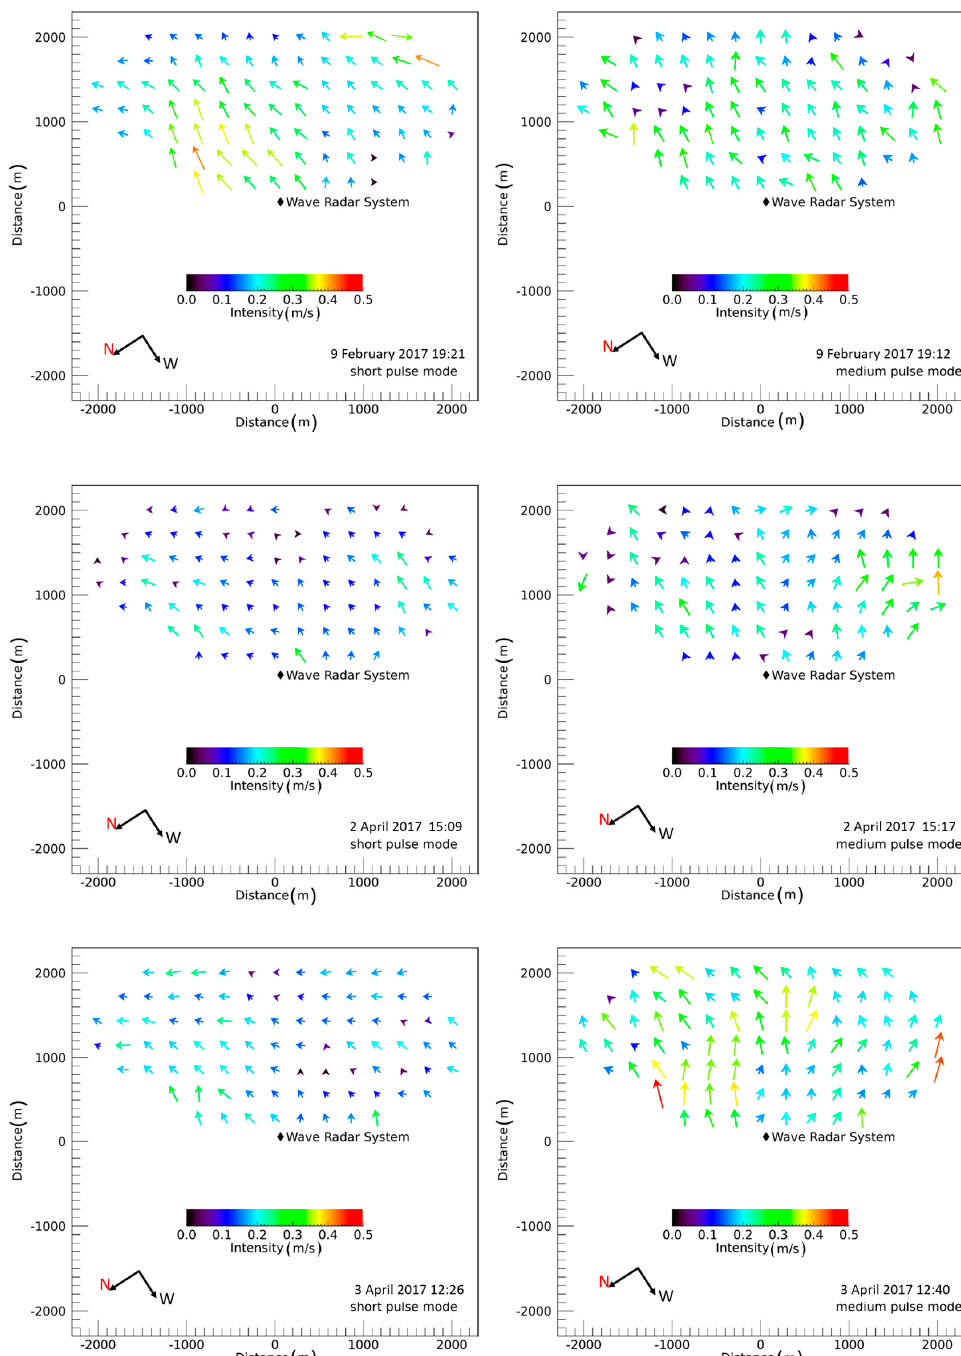
Figure 5. Map of the sea surface current reconstructed under the short ( left panel ) and medium ( right panel ) pulse mode.